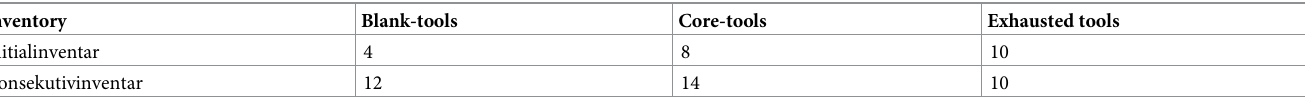
Table 12. Distribution of Keilmesser’s three different productional operational schemes for inventory type (from Richter 1997). Inventory